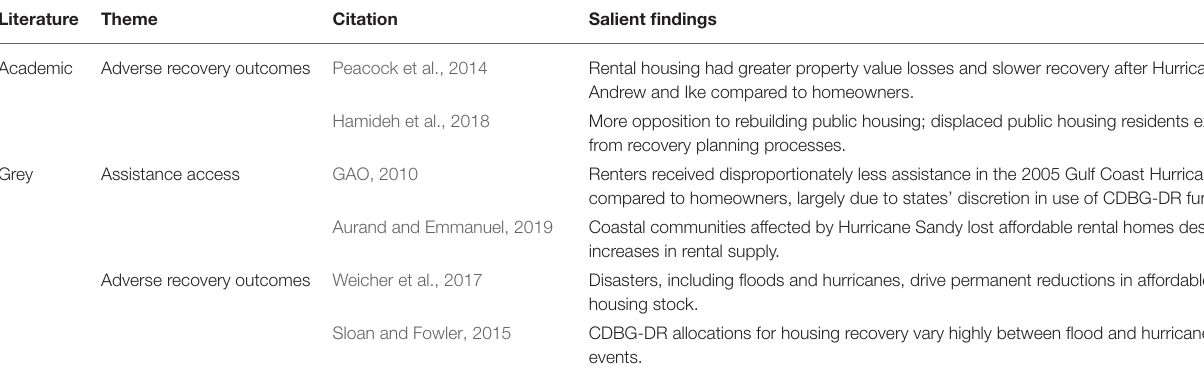
TABLE 2 | Key flood recovery studies focused on housing